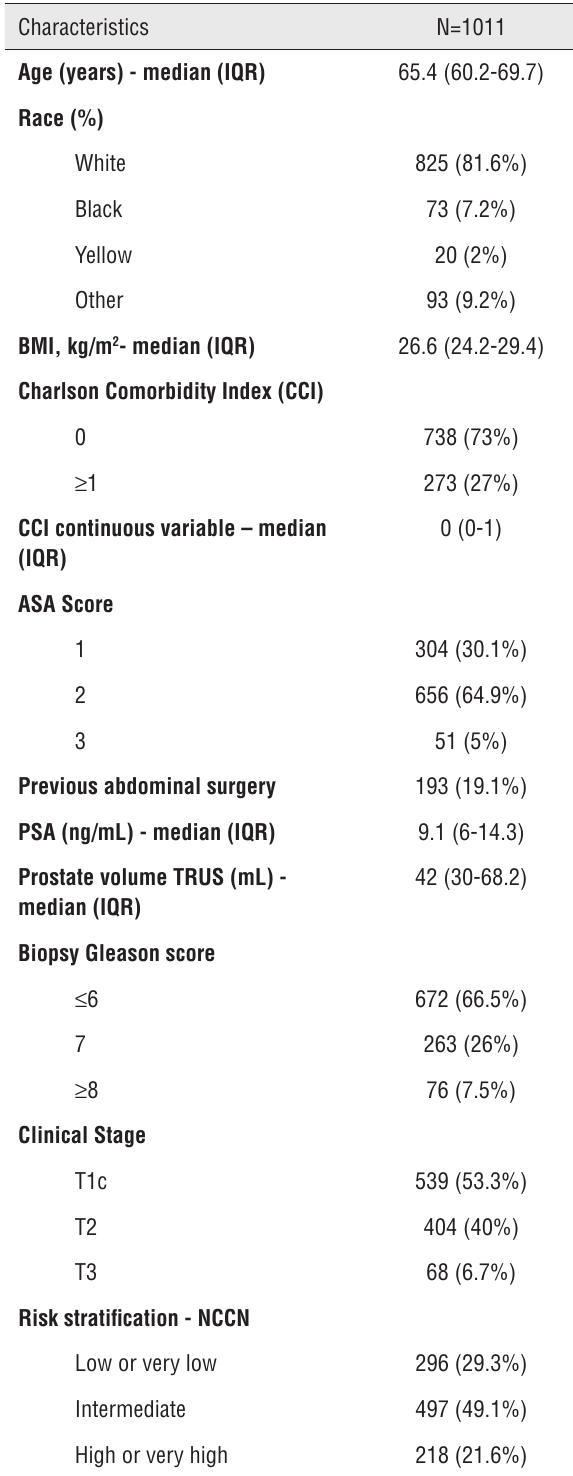
Table 2 – Pre-operative clinical, demographic, and pathologic